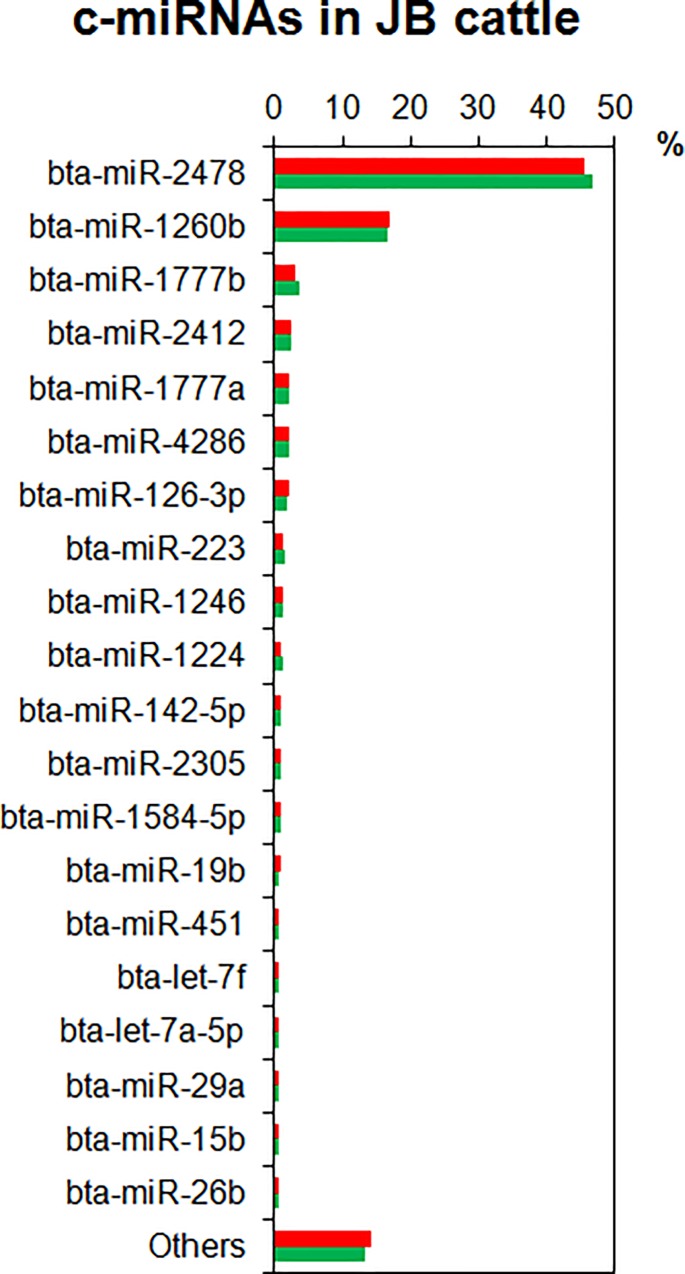
Circulating miRNA (c-miRNA) profiles in plasma extracellular vesicles of Japanese Black cattle obtained in microarray analysis.Percentages of c-miRNA contents in grain-fed (red bars) and grazing cattle (green bars) are indicated. The top 20 miRNAs in plasma of grazing cattle are listed.